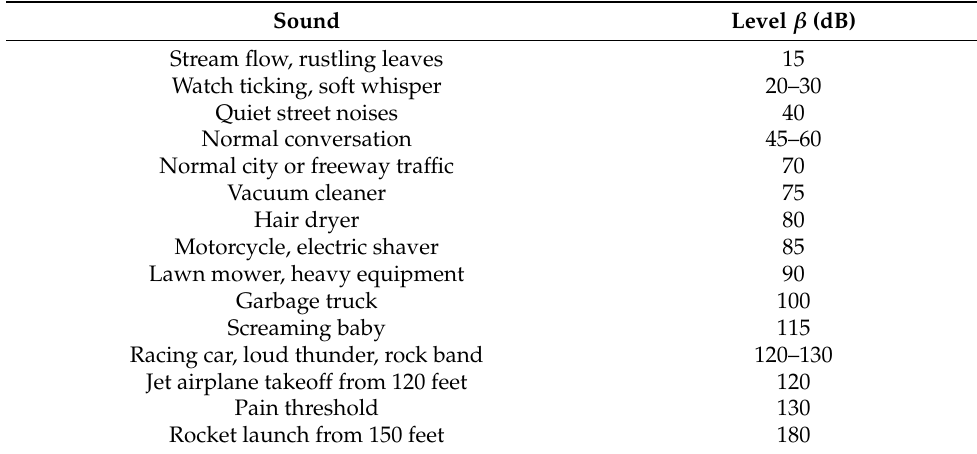
Table 4. General sound